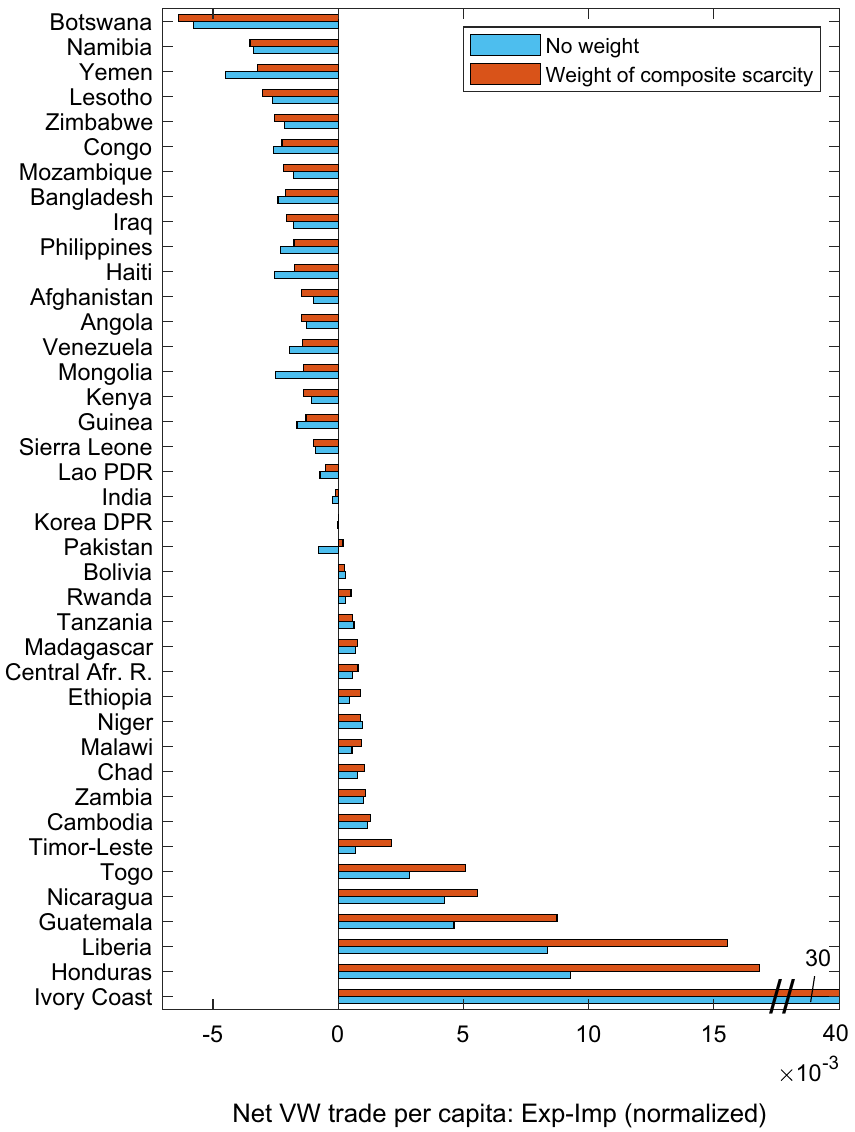
Figure 7. Net VW trade per capita status for 40 countries with the highest prevalence of undernourishment among the overall population, and with a composite water scarcity index higher than 0.5 (range: 0–1). Countries are ordered according to the share of CWSI-weighted VW trade per capita. Net trade is calculated as export minus import. Negative values refer to net importers and positive values refer to net exporters, expressed as world